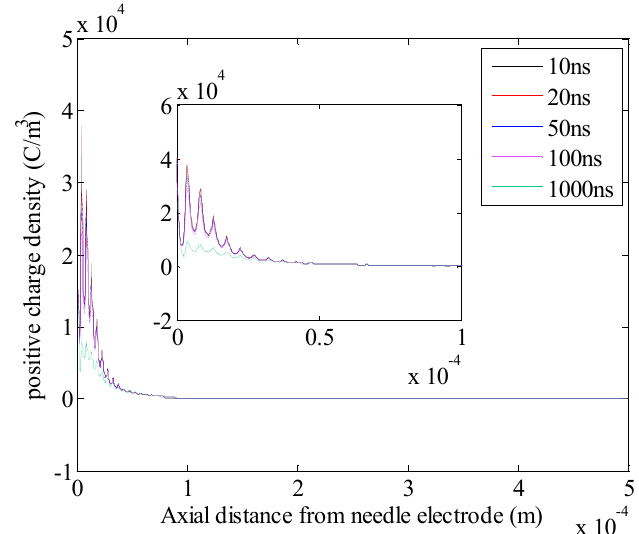
Figure 23. Positive charge density distribution along the needle-sphere axis as a response to 1.2 PDIV with 10 mm needle-plate electrode